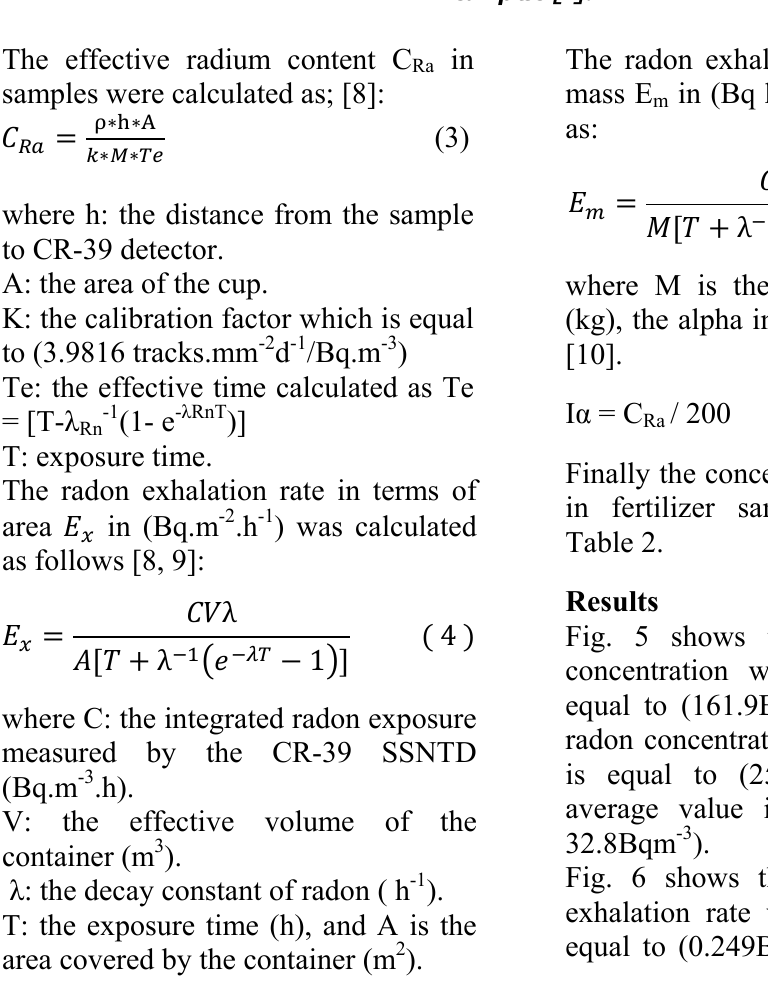
Fig. 4: The relation between radon gas concentration and track density in standard samples